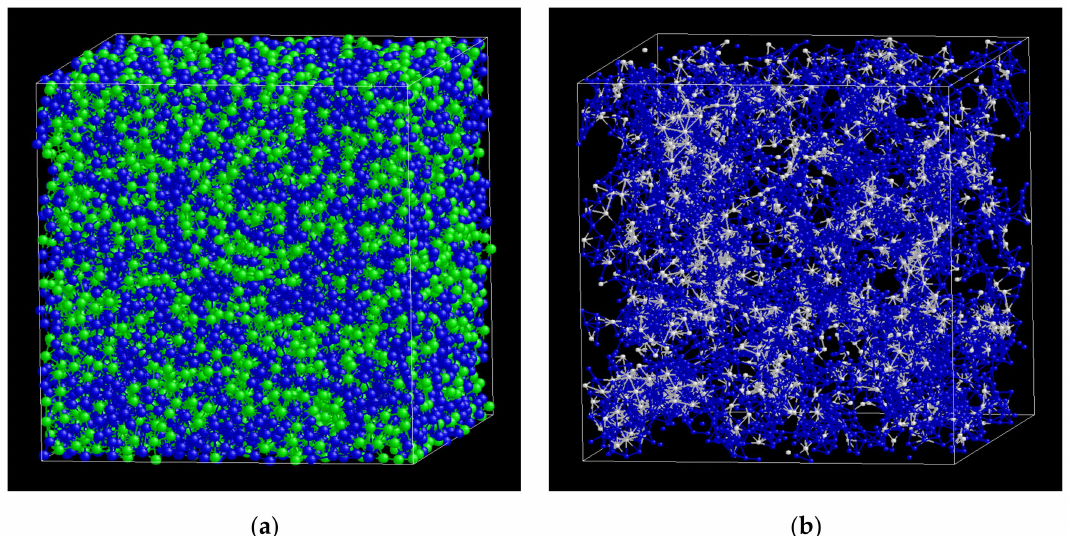
Figure 8. The network structure formed by I- and Z-clusters in an r BB = 0.8 A 40 B 60 glassy phases formed by middle-cooling: ( a ) All atoms belonging I- and Z-clusters in the network, where the green and blue spheres denote the A and B atoms, respectively. ( b ) The central atoms of I- and Z-clusters denoted by the blue and white spheres, respectively, together with the bicap-sharing connections between them.